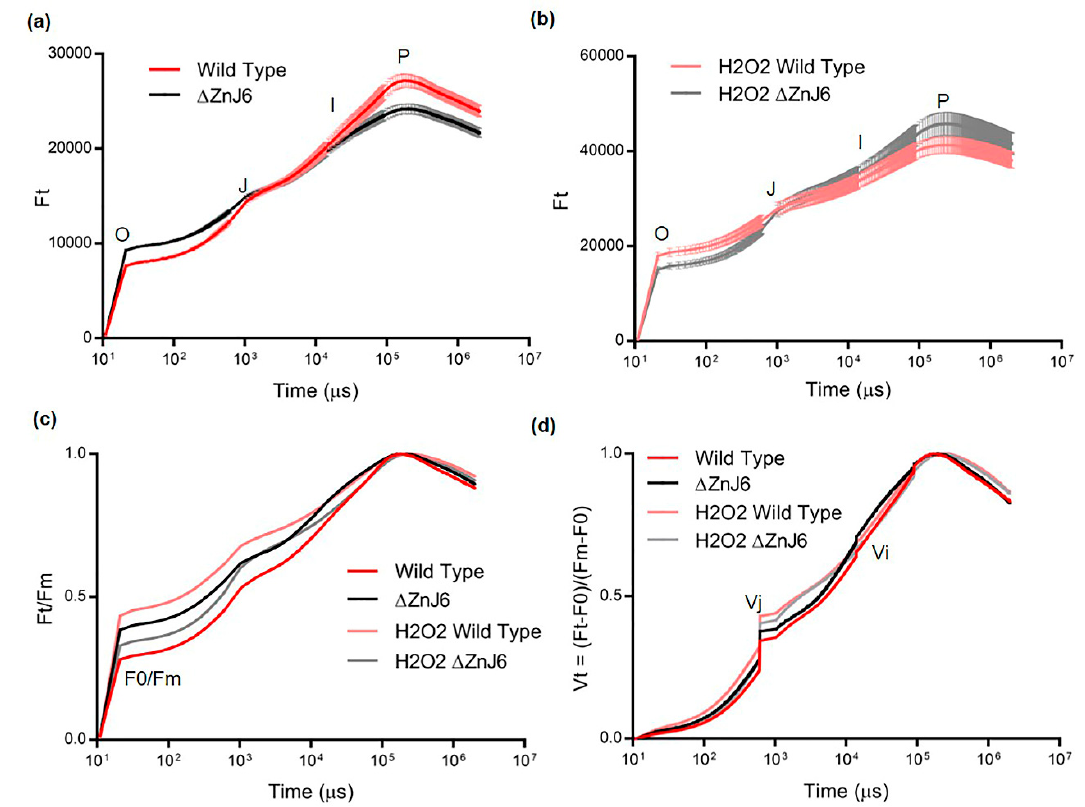
Figure 10. Differences in the photosynthetic efficiency of the Wild Type (WT) and ∆ ZnJ6 mutant under optimal and oxidizing conditions. ( a ) The originally measured chlorophyll a fluorescence induction kinetics (OJIP transient) of the WT and ∆ ZnJ6 Chlamydomonas cells under optimal environment, showing the polyphasic rise with minimum level fluorescence (O, corresponds to F0) and maximum (P, corresponds to Fm). The curve represents the mean of three independent experimental repeats, error bars represent standard deviations. Red and black curves represent WT and ∆ ZnJ6 values under normal conditions, respectively. ( b ) OJIP transient of WT and ∆ ZnJ6 Chlamydomonas cells under oxidizing conditions (2 mM H 2 O 2 for 1 h) also showing the polyphasic rise. The curve represents the mean of three independent experimental repeats, error bars represent standard deviations. Pink and gray curves represent WT and ∆ ZnJ6 values under oxidizing conditions, respectively. ( c ) Ft/Fm values of WT and ∆ ZnJ6 cells under optimal and oxidizing conditions. Curve colors are described in a and b. ( d ) The relative variable fluorescence (Vt) of WT and ∆ ZnJ6 Chlamydomonas cells under optimal and oxidizing conditions to compare the transient dynamics of the OJIP curve obtained for the WT and ZnJ6 cells. The curve was generated from the mean values obtained from three independent experimental repeats. Curve colors are described in a and b . Ft = chlorophyll fluorescence at time t. F0 = fluorescence intensity at 50 µ s (O). It is the minimum fluorescence from dark-adapted cells. Fm = maximal fluorescence intensity at peak P. Vt = (Ft − F0)/(Fm − F0) represents values that were double normalized to Fm and F0. Vj and Vi = relative variable fluorescence at the intermediate J and I step,